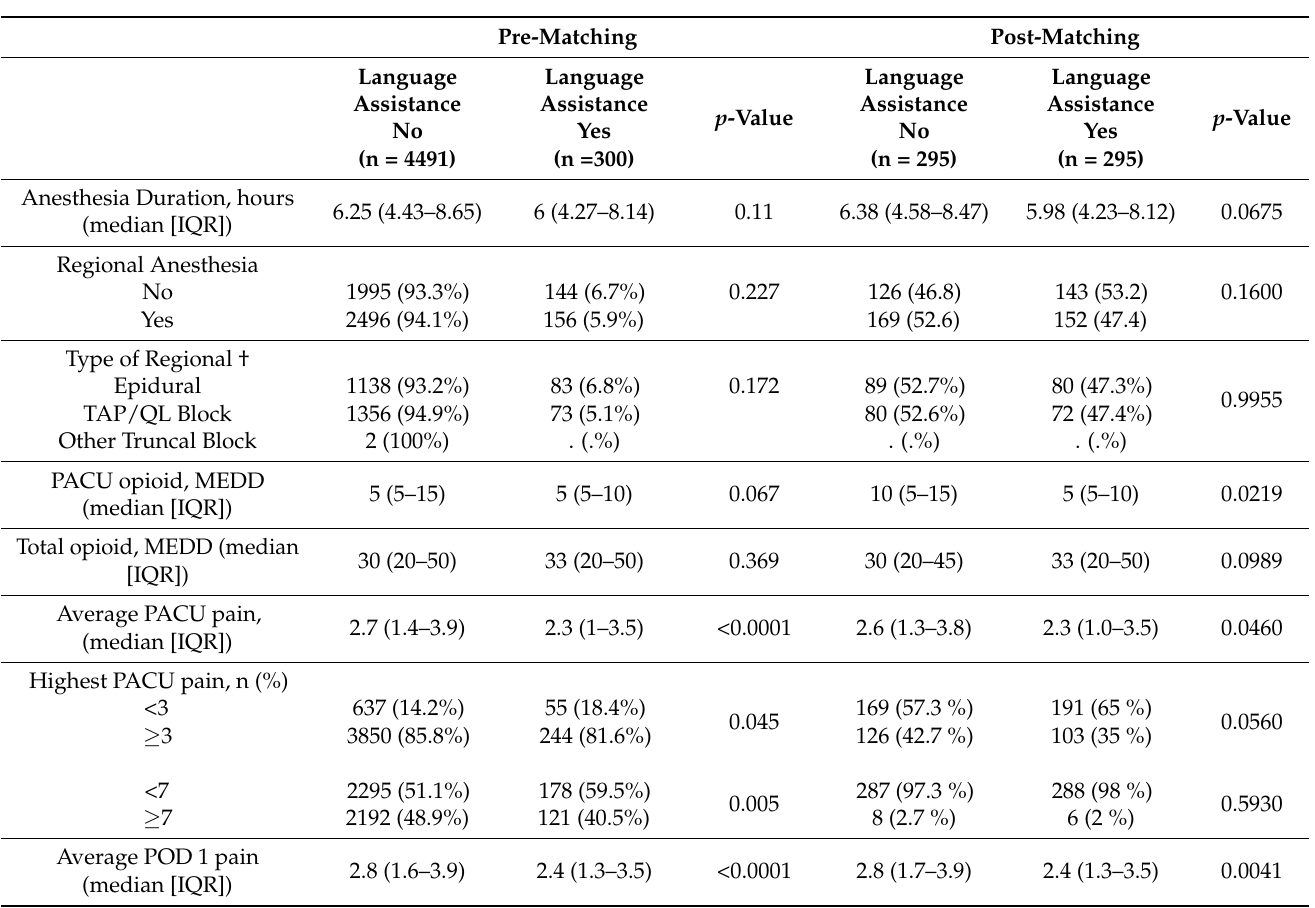
Table 2. Regional anesthesia and perioperative opioid utilization, postoperative pain scores and types of surgeries